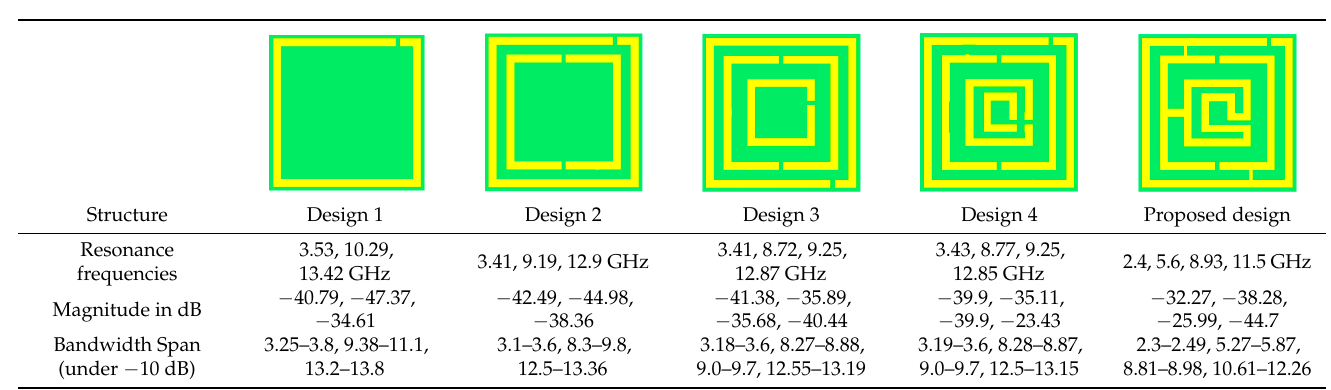
Figure 5. Simulation setup of metamaterial unit cell in computer simulation technology (CST). Table 2. Proposed unit cell parameters values.